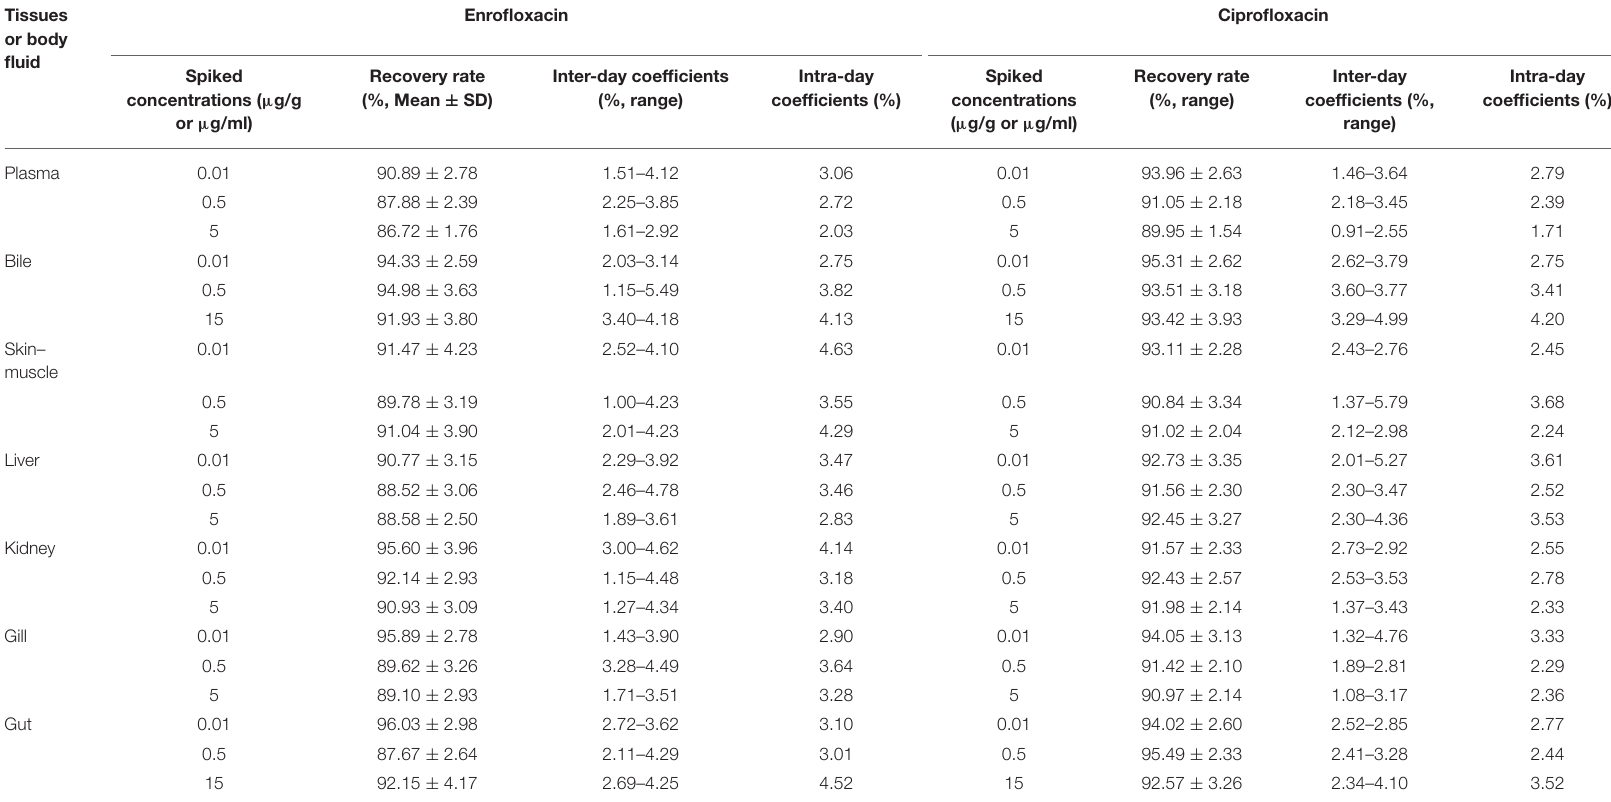
TABLE 1 | The results of the analytical method for the determination of enrofloxacin and ciprofloxacin concentrations in fish tissues and body fluid. Tissues or